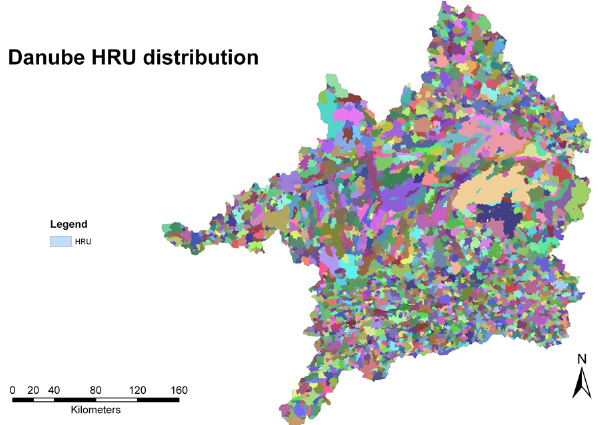
Figure 12. HRUs delineation for the UDRB.